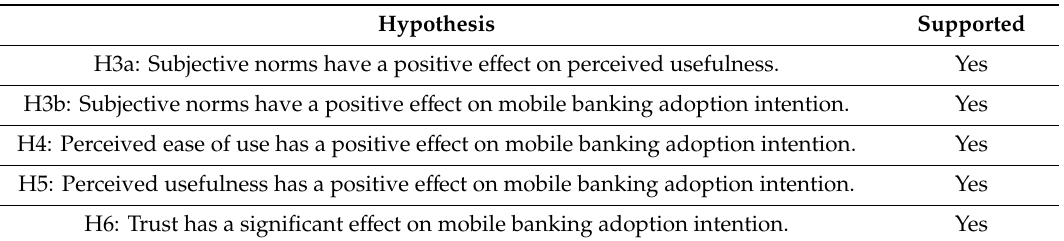
Table 8. Cont. Hypothesis